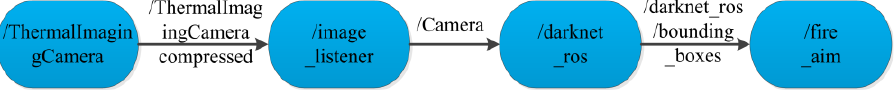
Figure 14. ROS node diagram of the automatic fire-extinguishing system.